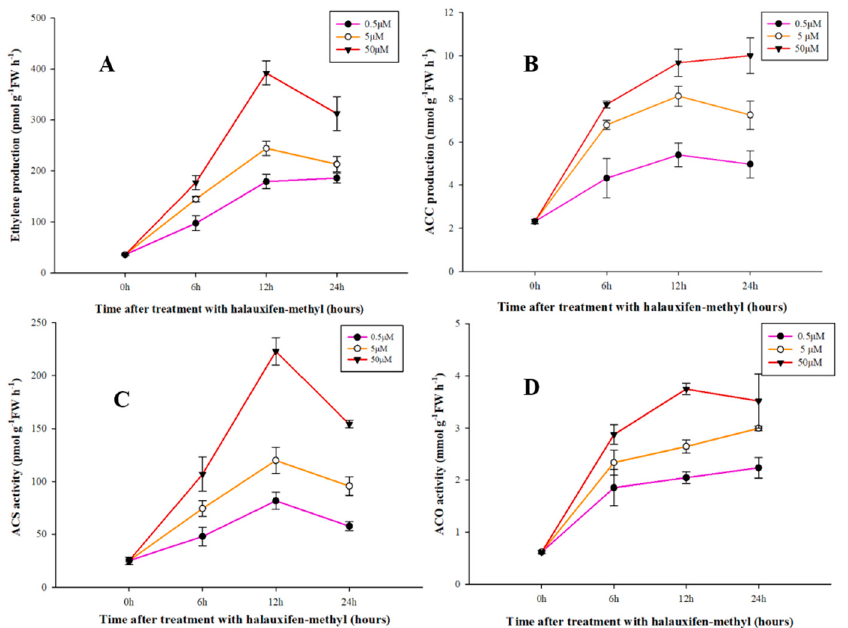
Figure 3. The effect of halauxifen-methyl on the ethylene production capacity ( A ), ACC contents ( B ), ACC synthase activity ( C ), and ACC oxidase activity ( D ) of the treated Galium aparine . Data are expressed as percentages of the mean values for untreated control plants. Vertical bars represent the standard errors of the means.